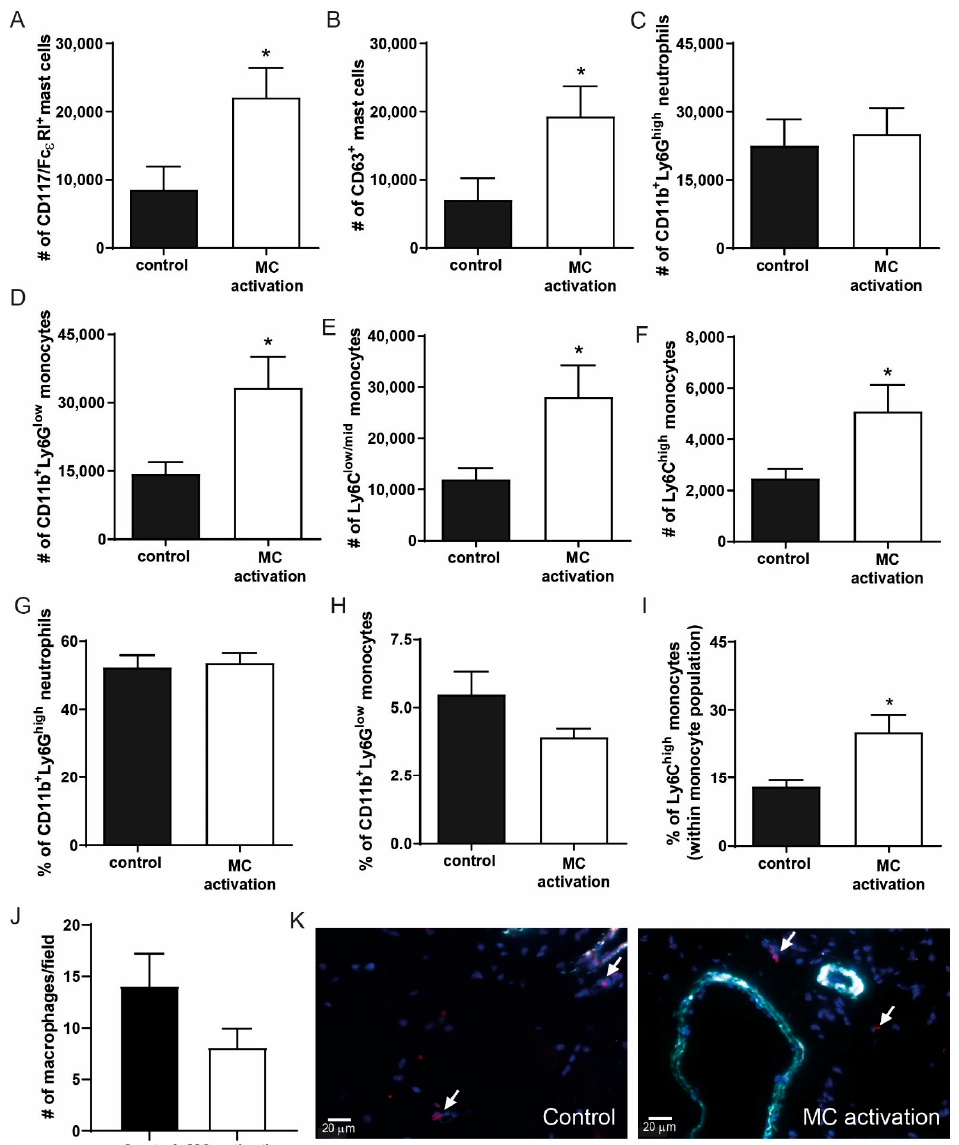
Figure 7. Inflammatory cell analysis in the ischemic hind limb at nine days after ischemia induction. ( A ) Total CD117 + Fc ε RI + mast cell numbers and ( B ) the number of CD63 + activated mast cells were measured in the inguinal lymph node (iLN) draining from the ischemic hind limb of mice in the DNP-group and the controls using flow cytometry. ( C ) The number of CD11b + Ly6C high neutrophils in the iLN. ( D ) The number of CD11b + Ly6G low monocytes of which, ( E ) Ly6C low/mid and ( F ) Ly6C high monocytes. ( G ) Percentage of neutrophils, ( H ) percentage of total monocytes, and ( I ) percentage of inflammatory monocytes within the total monocyte population were measured in the circulation of control mice vs. mice in which mast cells were activated. ( J ) The number of macrophages per microscopic field in the ischemic soleus muscles of mice in which mast cells were activated vs. controls at nine days after ligation. ( K ) Representative micrographs of macrophages in red (indicated by arrows) and aSMA + collaterals in cyan and nuclei (DAPI) in blue. * p <